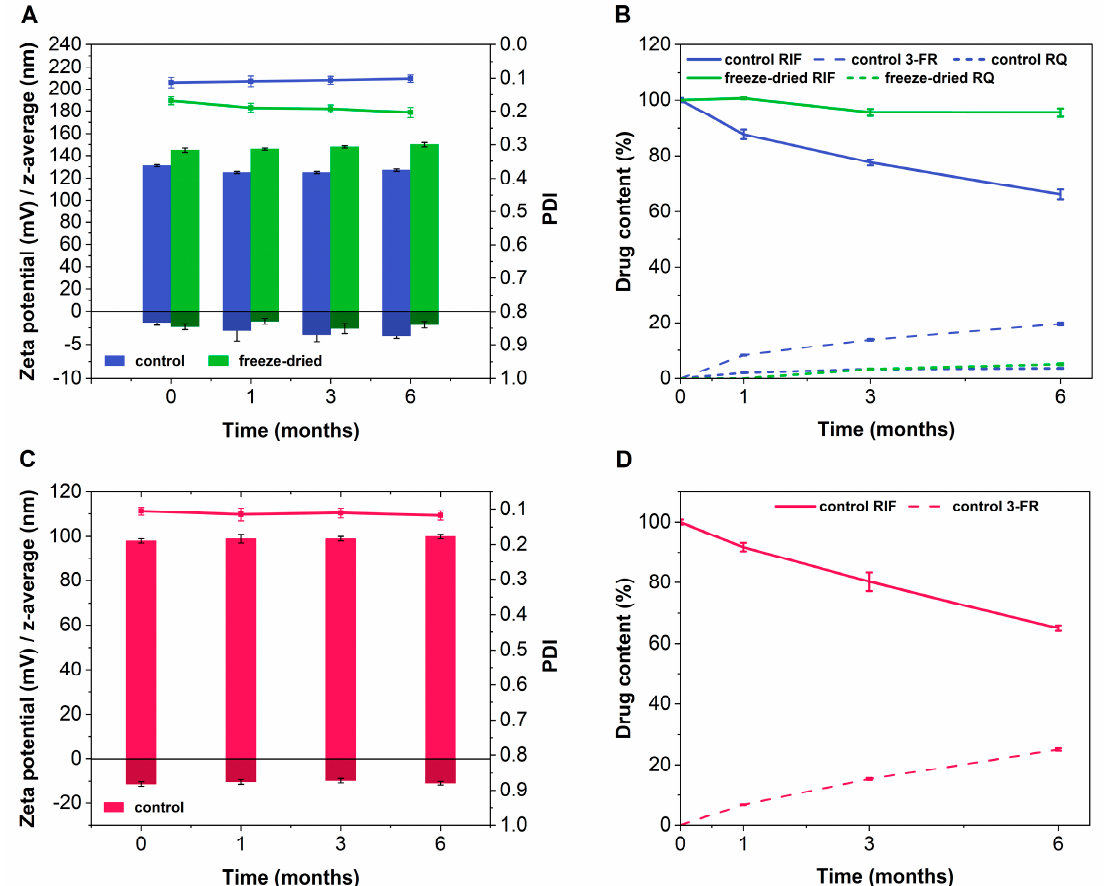
Figure 6. Comparison of physical ( A , C ) stability including particle size (left axis, light green, blue and red bars), zeta potential (left axis, dark green, blue and red bars), and PDI (green, blue, and red line) and chemical ( B , D ) stability of HPMC gel ( A , B ) and hyaluronic acid plus collagen gel ( C , D ) over 6 months (mean values ± SD, n = 3).